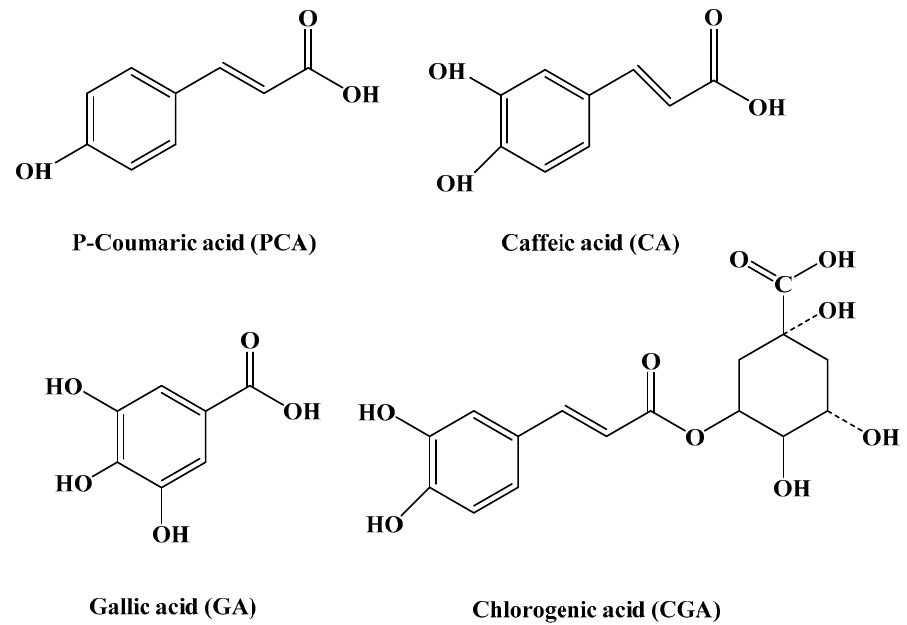
Figure 1. Chemical structures of the four phenolic acids (PCA, CA, GA and CGA).